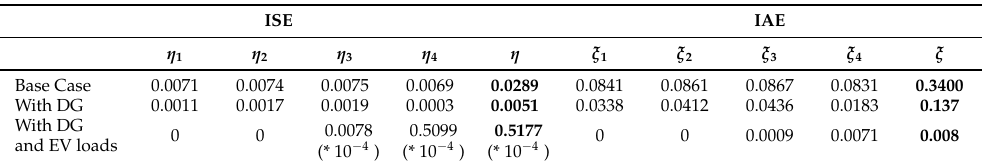
Table 3. Performance comparison of